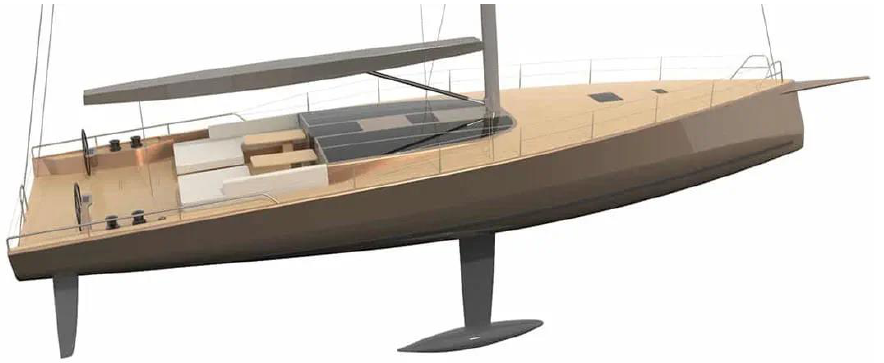
Figure 17. Baltic yachts made from flax-fibre-reinforced composites (source: Baltic yachts made from flax-fibre-reinforced composites (source: https://www.